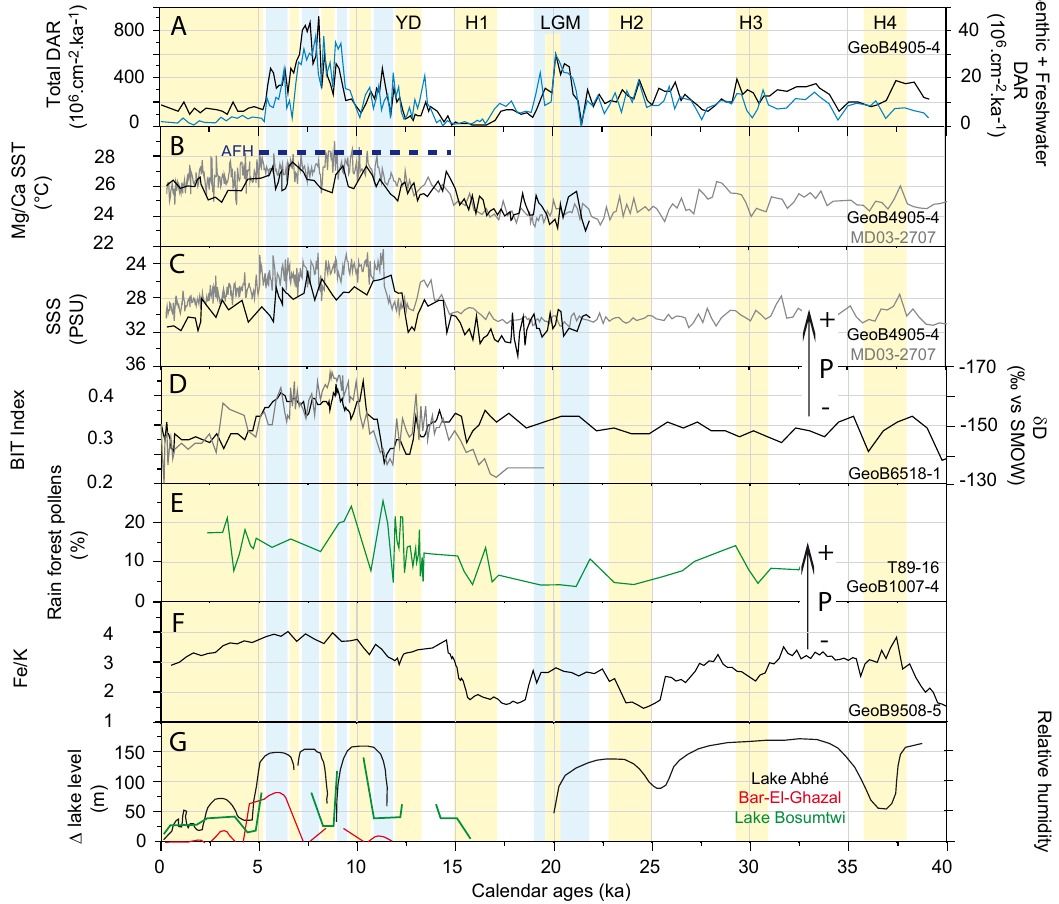
Fig. 5. Comparison of diatom and biogenic silica accumulation rates recorded in core GeoB4905-4 with climate proxies from Equatorial Africa. (A) Total diatom accumulation rates (black curve) and freshwater + marine/brackish benthic diatom accumulation rates (blue curve), (B) eastern Equatorial Atlantic sea-surface temperatures in core GeoB4905-4 (black line, Weldeab et al., 2007a) and in core MD03-2707 (grey line, Weldeab et al., 2007c), (C) eastern Gulf of Guinea sea-surface salinities in core GeoB4905-4 (black line, Weldeab et al., 2005) and in core MD03-2707 (grey line, Weldeab et al., 2007c), (D) BIT index tracing the input of continental organic carbon to the eastern equatorial Atlantic (black line, Weijers et al., 2009) and relative changes in central African humidity based on δ D values of plant wax n -C 29 alkanes (grey line, Schefuss et al., 2005), (E) proportion of lowland rainforest pollens in cores T89-16 and GeoB1007-4 (Marret et al., 2008), (F) elemental Fe/K ratio in core GeoB9508-5 off Senegal River (Mulitza et al., 2008), (G) lake level height above present level in Lake Abhe (11 ◦ 05 0 N–41 ◦ 50 0 E, black curve) and Bar-El-Ghazal (18 ◦ N 17 ◦ E, red curve) (Gasse, 2000) and relative humidity inferred from Lake Bosumtwi (green curve; Peck et al., 2004). P : inferred precipitations over western Equatorial